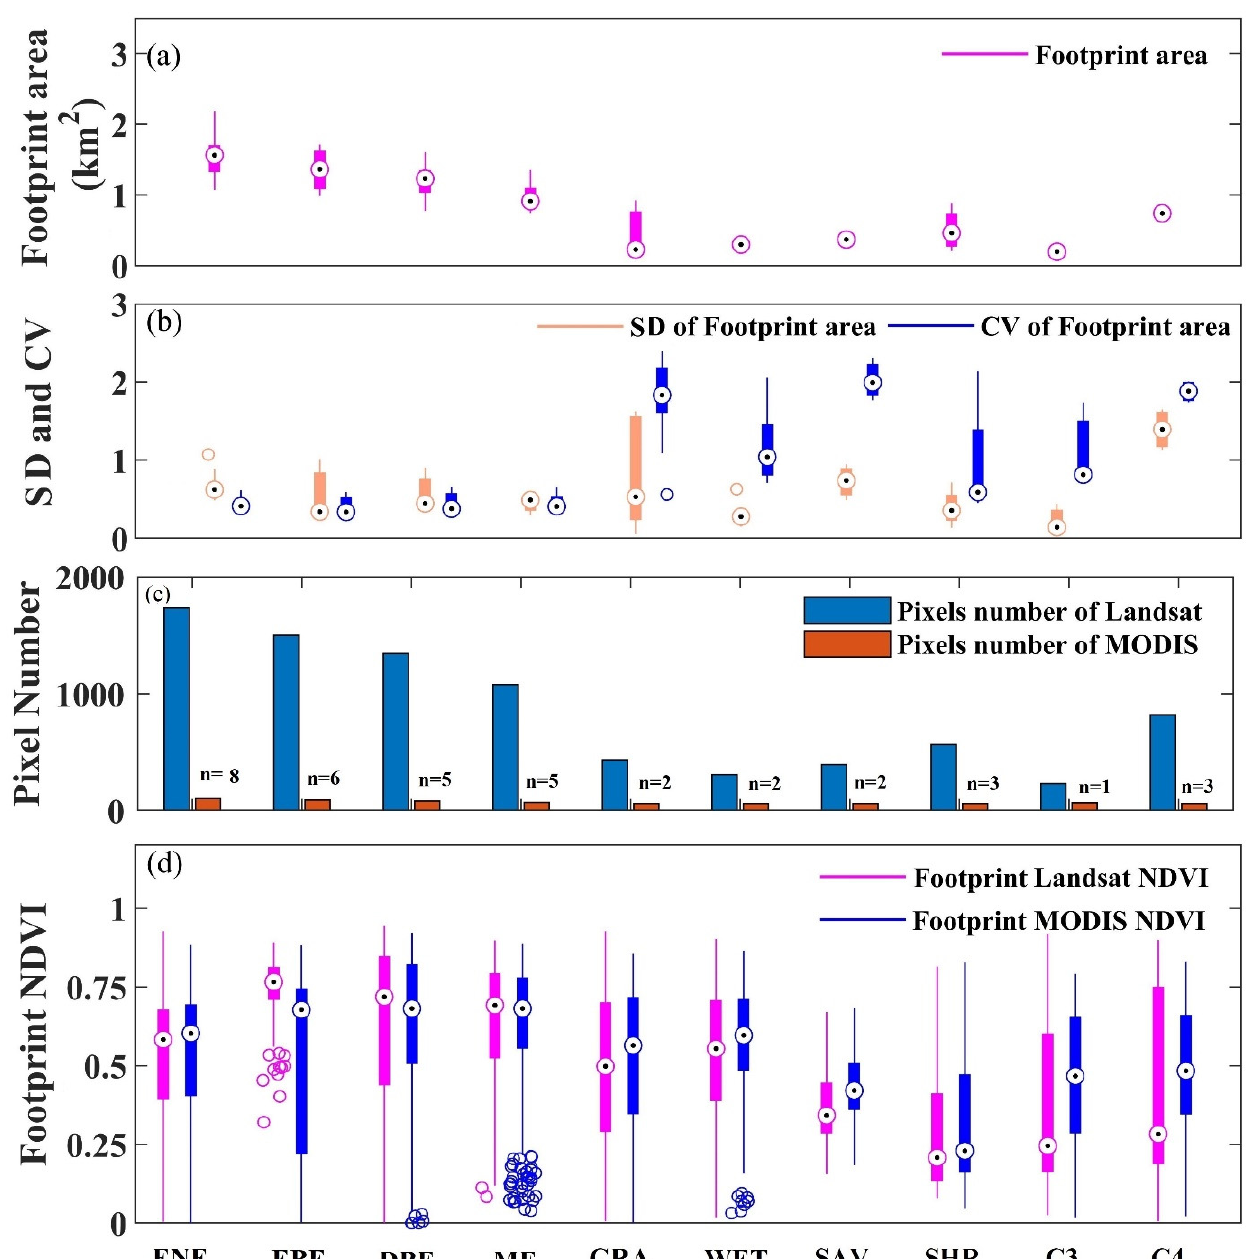
Figure 4. ( a ) Boxplot of the footprint area across 10 vegetation types; ( b ) the boxplot of standard deviation (SD) and coefficient of variation (CV) of footprint for each vegetation types; ( c ) the number of pixels required to cover the footprint area using Landsat satellite NDVI with a 30 m spatial resolution and using MODIS NDVI with 500 m spatial resolution, respectively; ( d ) the footprint NDVI, Landsat, and MODIS satellite for each vegetation type. The biome types are as follows: deciduous broadleaf forest (DBF); evergreen broadleaf forest (EBF); evergreen needleleaf forest (ENF); mixed forest (MF); grasslands (GRA); savannas (SAV); Shrublands (SHR); wetlands (WET); C3 cropland (C3); C4 cropland (C4).